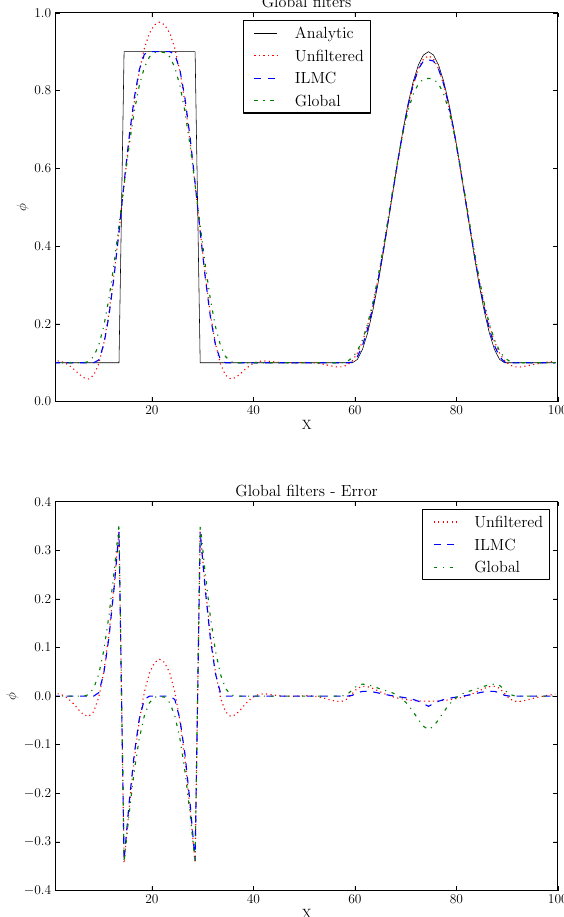
Fig. 3. Filtering: mass-conserving and shape-preserving global filter compared with mass-conserving and shape-preserving local filter. Fig. 3. Filtering: Mass conserving and shape preserving global filter compared against mass conserving The top panel shows the solution after two revolutions, where the and shape preserving local filter. The top panel shows the solution after 2 revolutions, where the solid solid line (black) is the analytical solution, the dotted (red) line is line (black) is the analytical solution, the dotted (red) line is the unfiltered LMCSL solution, the dashed the unfiltered LMCSL solution, the dashed (blue) line is the local (blue) line is the local ILMC filter, and the dot-dashed (green) line is the global shape preserving filter. ILMC filter, and the dot-dashed (green) line is the global shape- 28 preserving filter. The bottom panel shows the difference between The bottom panel shows the difference between the analytical solution and the individual simulations. the analytical solution and the individual